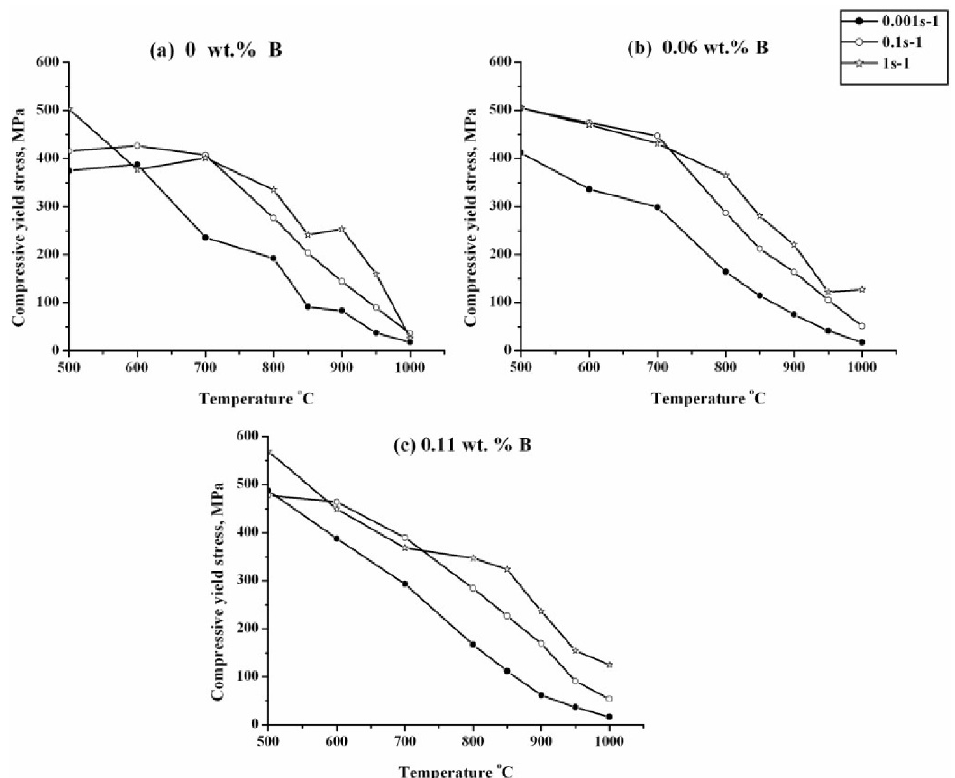
Figure 9. Variation of compressive yield strength ( σ y at 0.2% strain) with temperature for different strain